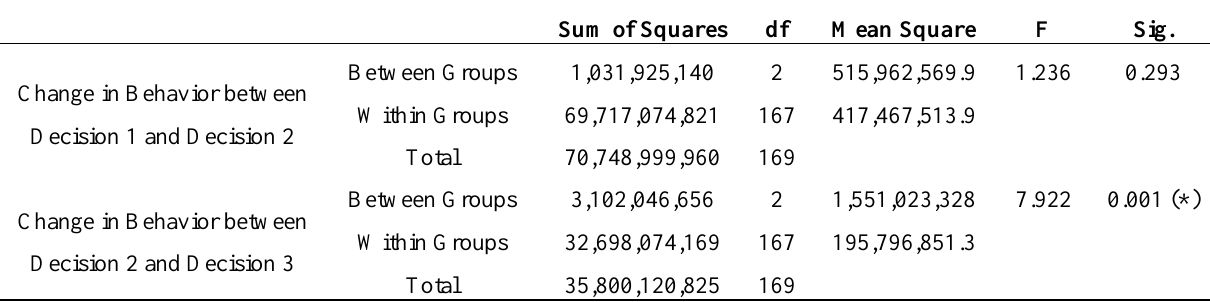
Table 4. One-Way ANOVA of Feedback